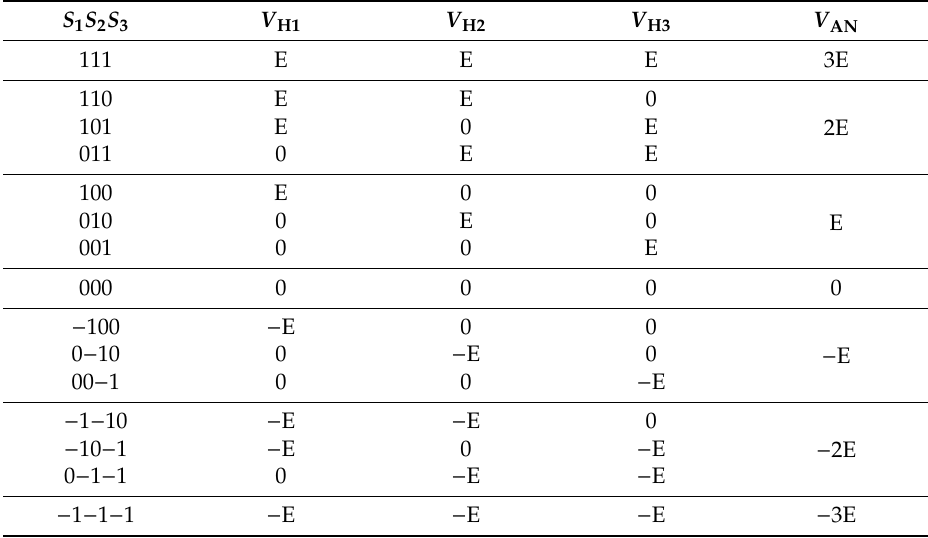
Table 1. The outputs corresponding to di ff erent output state